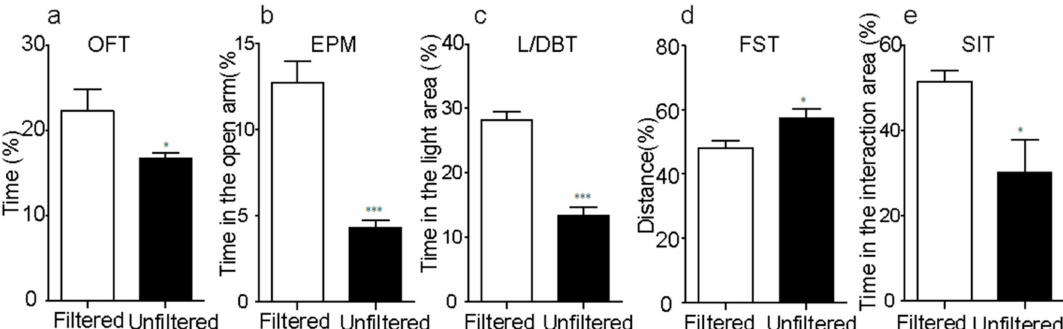
Figure 2. Exposure to ambient air particles provokes mood-related behaviors disorder. ( a – c ) Unfiltered mice spend less time in the center area of the open field arena in the open field test (OFT) ( p < 0.05, t18 = 2.161), the open arm of the elevated plus maze test (EPM) ( p < 0.001, t18 = 6.333) and the light side of the light-dark box test (L/DBT) ( p < 0.001, t18 = 7.776). ( d ) Unfiltered mice displayed significantly more immobility than filtered mice in forced swim test (FST) ( p < 0.01, t18 = 3.688). ( e ) The time in the interaction area of unfiltered mice was less than that of filtered mice in social interaction test (SIT) ( p < 0.05, t18 = 2.583). * p < 0.05; *** p <